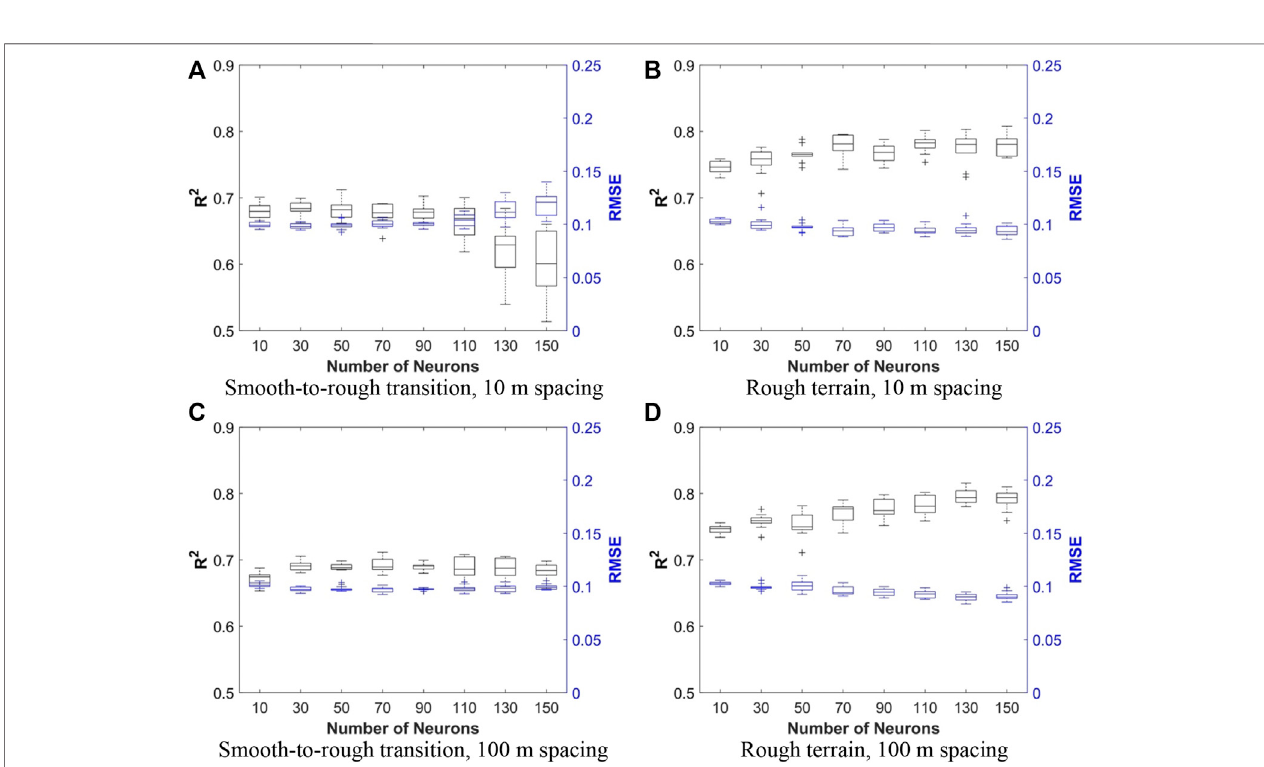
FIGURE 9 | Coef fi cients of determination for varied neuron counts and horizontal spacing between elevation data points in the DEM for the single layer neural network. (A) Smooth-to-rough transition, 10 m spacing. (B) Rough terrain, 10 m spacing. (C) Smooth-to-rough transition, 100 m spacing. (D) Rough terrain, 100 m